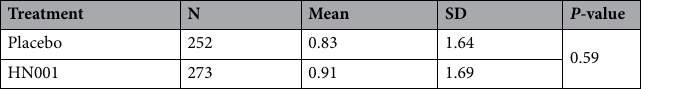
Table 3. Mean illness days per week for weeks 2–12 of the trial for the probiotic and placebo groups.